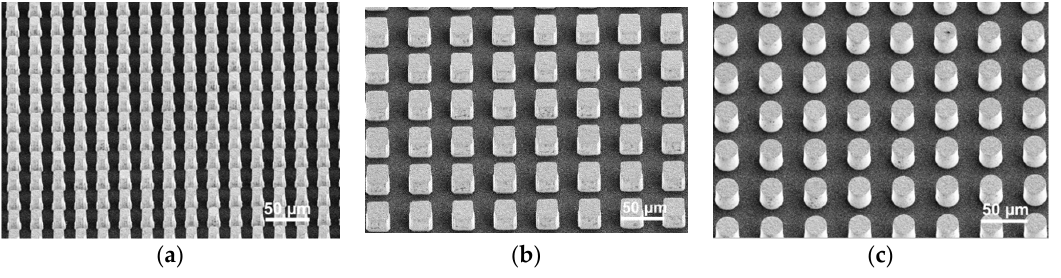
Figure 3. SEM overview images of two-dimensional X-ray gratings with 28 µ m gold height: ( a ) 25 µ m period pattern; ( b ) 50 µ m period square shape pattern; and ( c ) 50 µ m period round pattern.